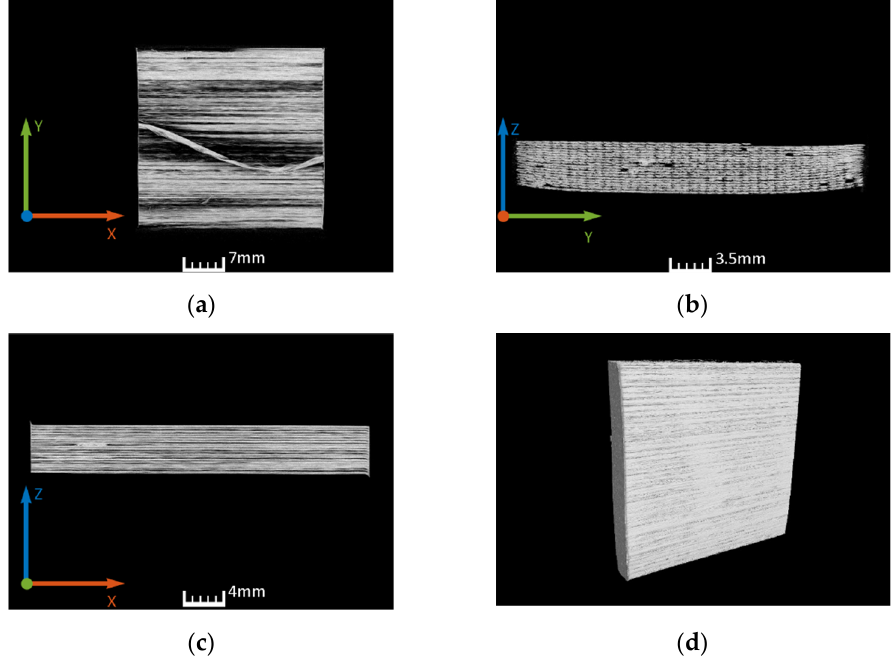
Figure 8. CT scan of the unconsolidated blockply specimen: ( a ) xy-plane crossection; ( b ) xz-plane crossection; ( c ) xz-plane crossection; ( d ) 3D overview.